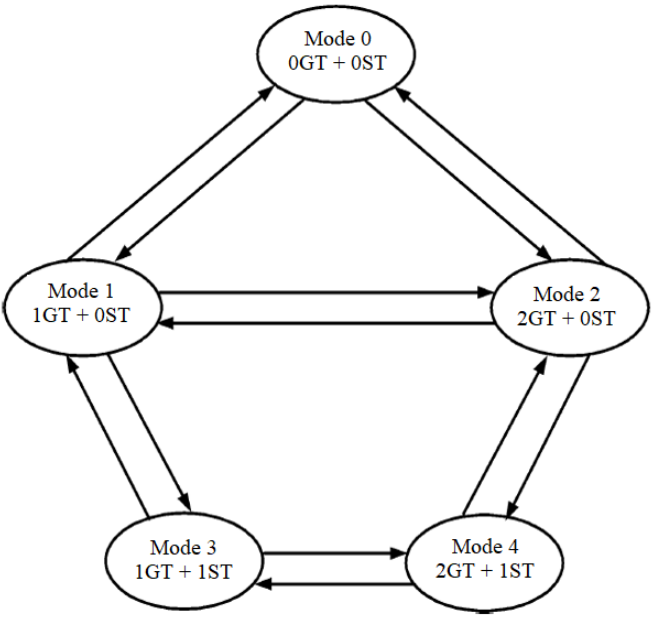
Figure 2. State transition diagram for CCGT with two GTs and one ST [17].